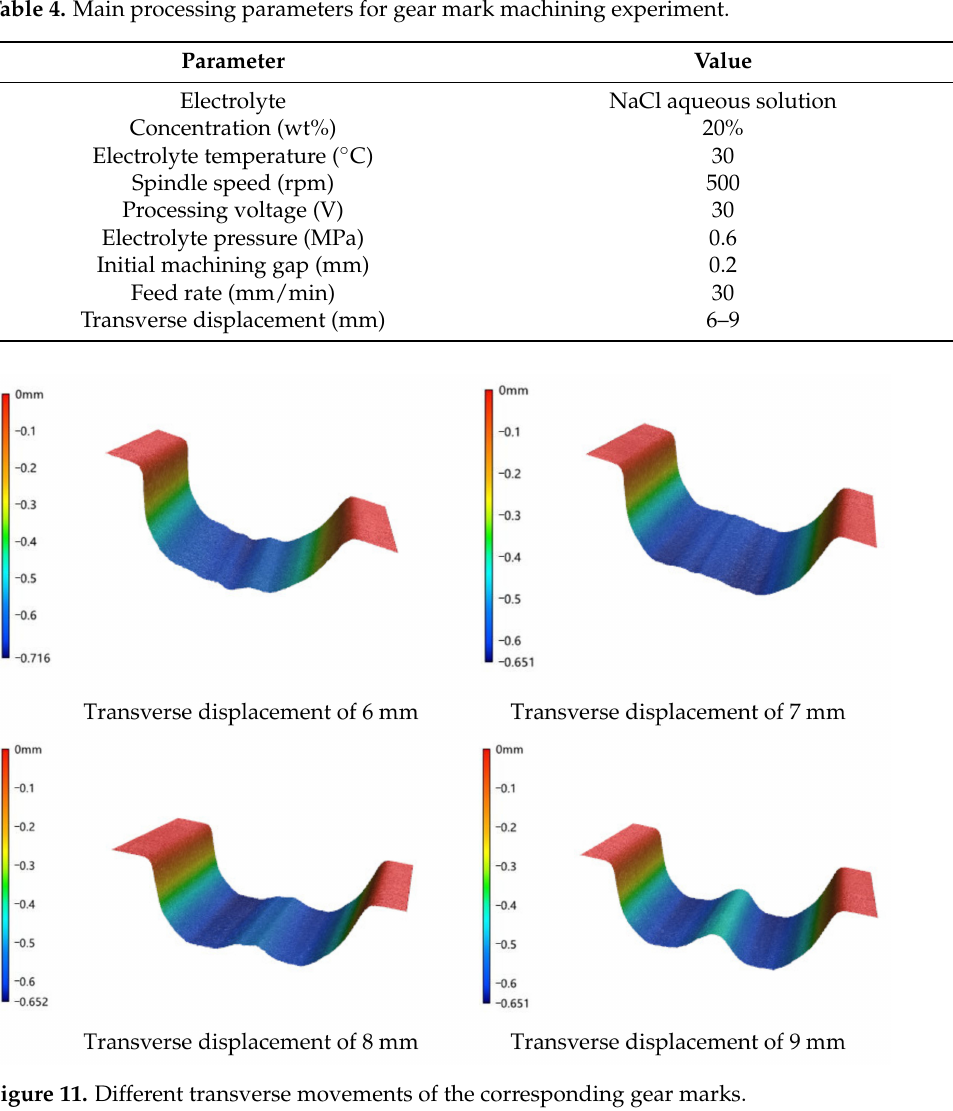
Table 4. Main processing parameters for gear mark machining experiment.